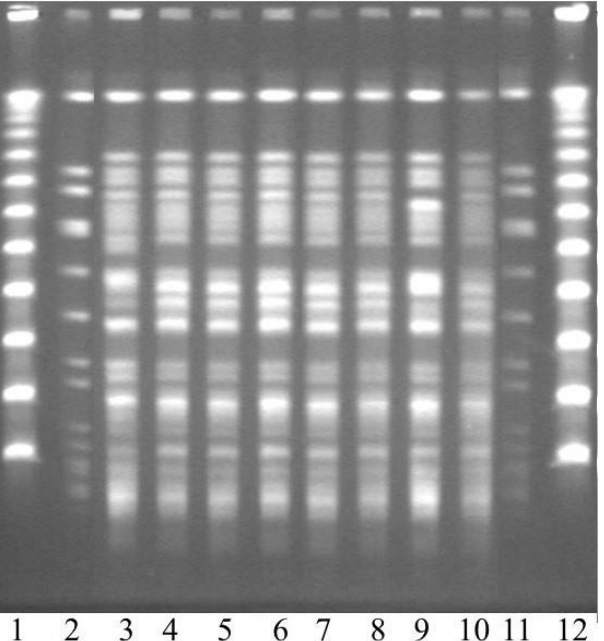
Figure 1. Pulsed-field gel electrophoresis of the patient isolates. Lanes 1 and 12: DNA size markers; lanes 2 and 11: a control strain; and lanes 3–10: patient isolates from the outbreak in the same order as they were isolated.